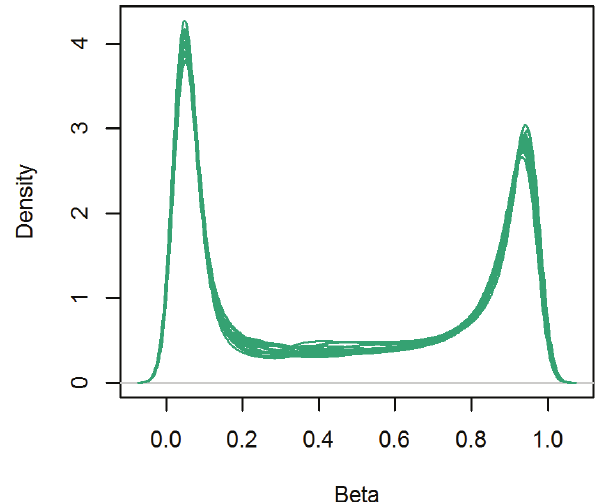
Figure 2. Density of β -values after normalization for all twin